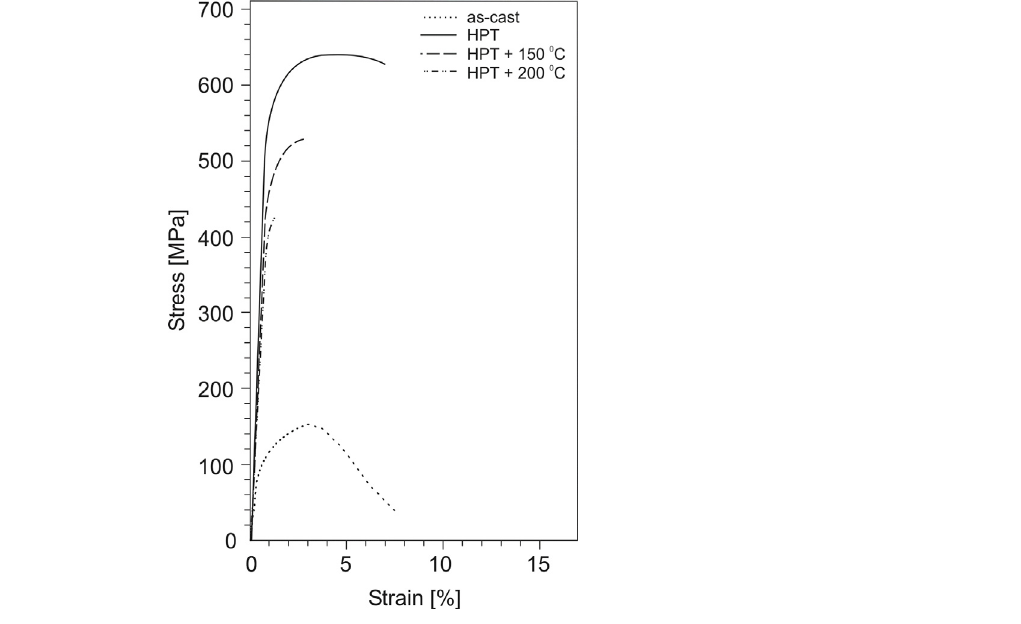
Figure 9. Stress–strain curves for tensile test specimens of the Al–7% Ni alloy in as-cast state, after HPT, and subsequent annealing. Table 2. Mechanical properties of eutectic aluminum alloys in as-cast state and after